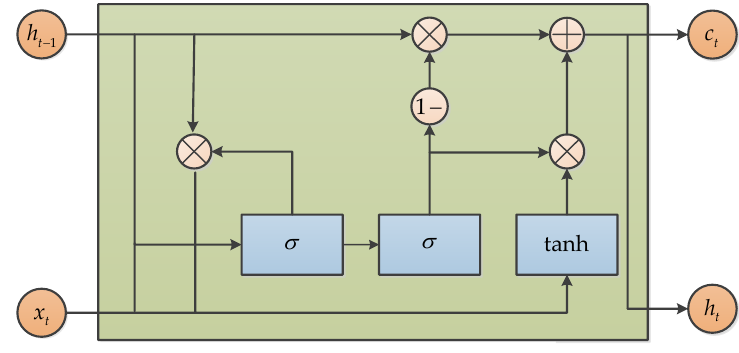
Figure 19. The structure of Gated Recurrent Unit.